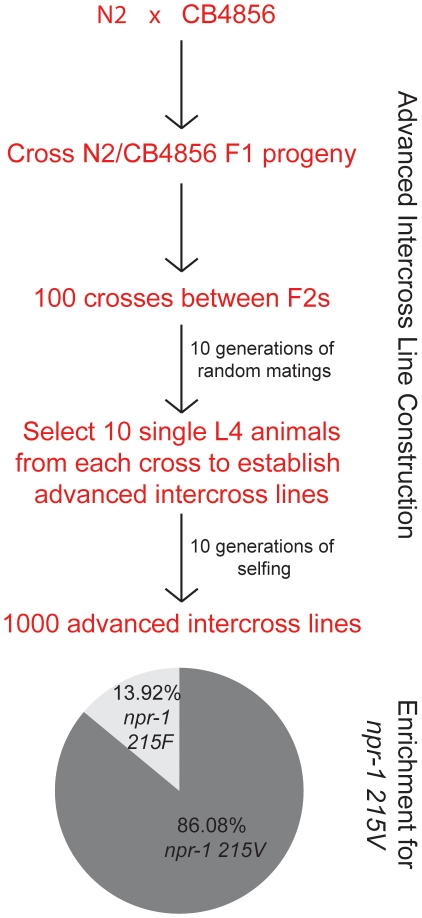
Laboratory cultivation selects for solitary feeding.The flowchart describes construction of advanced intercross lines, which yielded many more strains carrying the 215V allele of npr-1 than the npr-1 215F variant.